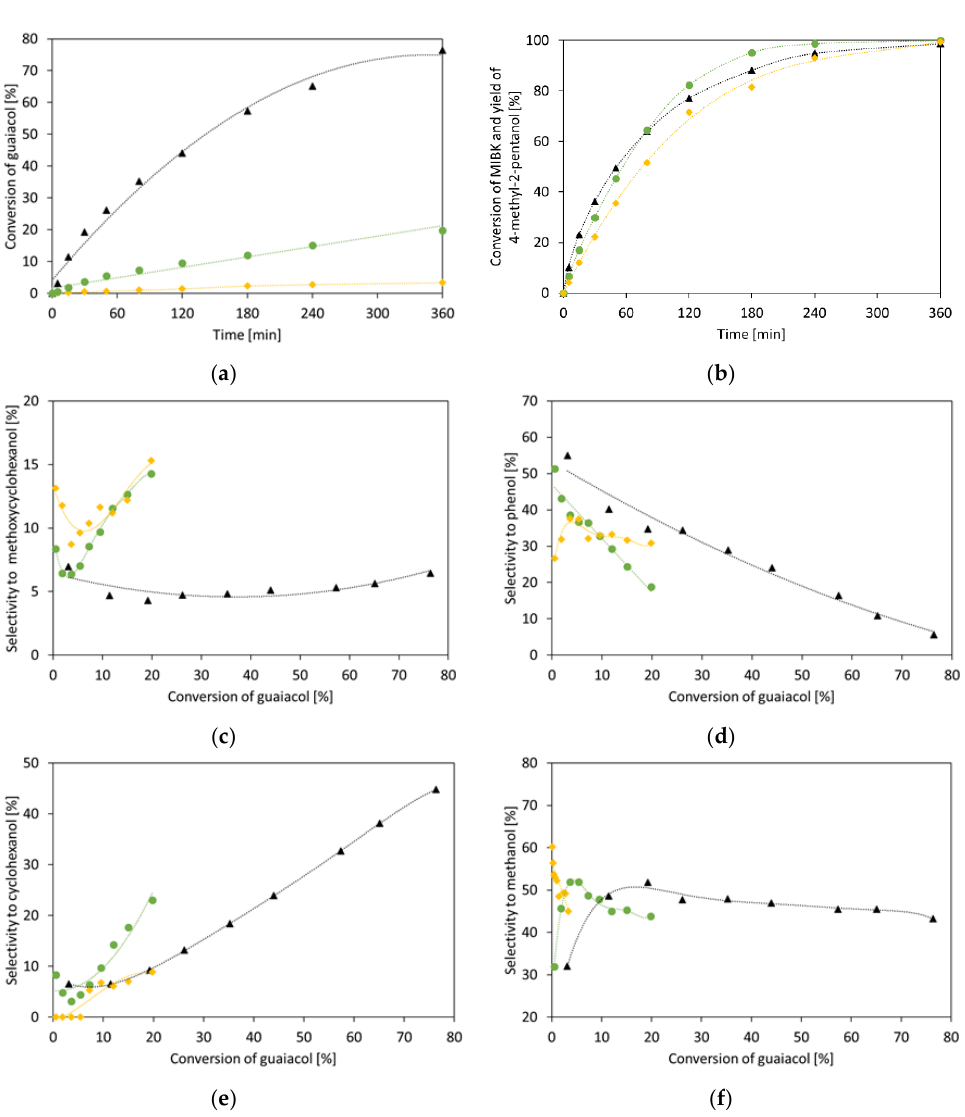
Figure 9. ( a ) Conversion of guaiacol; ( b ) Conversion of MIBK and yield of 4-methyl-2-pentanol. Selectivity to ( c ) methoxycyclohexanol, ( d ) phenol, ( e ) cyclohexanol, and ( f ) methanol at 30, 50, and 70 ◦ C in 50:50 mixtures of guaiacol:MIBK